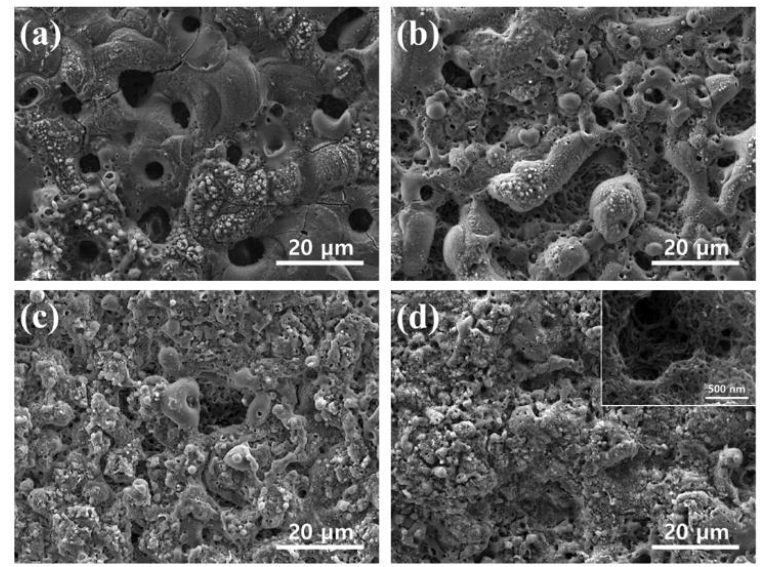
Figure 4. Scanning electron microscopy (SEM) micrographs of the surface morphologies of PEO coatings in different concentration of CNT: ( a ) 0 g/L CNT; ( b ) 2.5 g/L CNT; ( c ) 5 g/L CNT; and ( d ) 10 g/L CNT; the inset is the SEM image of the incorporated CNT.